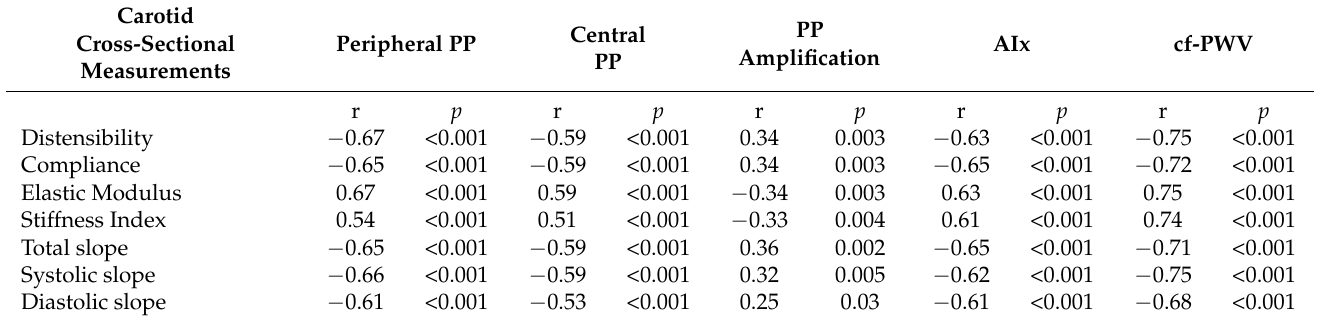
Table 3. Bivariate analysis (Spearman’s correlation coefficient) between carotid cross-sectional disten- sibility measurements and main hemodynamic parameters, derived from central pulse wave analysis, and carotid–femoral PWV.